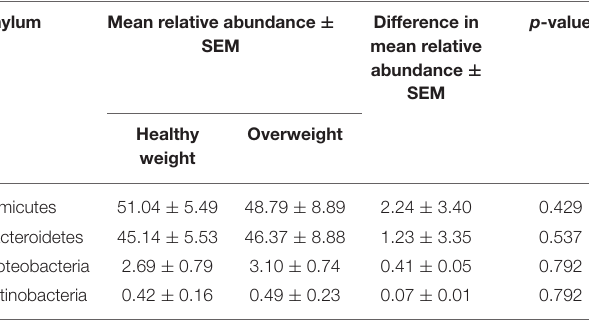
TABLE 2 | Mean difference in the relative abundance of the phyla Firmicutes, Bacteroidetes, Proteobacteria, and Actinobacteria in healthy subjects stratified according to BMI status. Healthy weight (BMI of 20–25kg/m 2 ), overweight (BMI of > 25kg/m 2